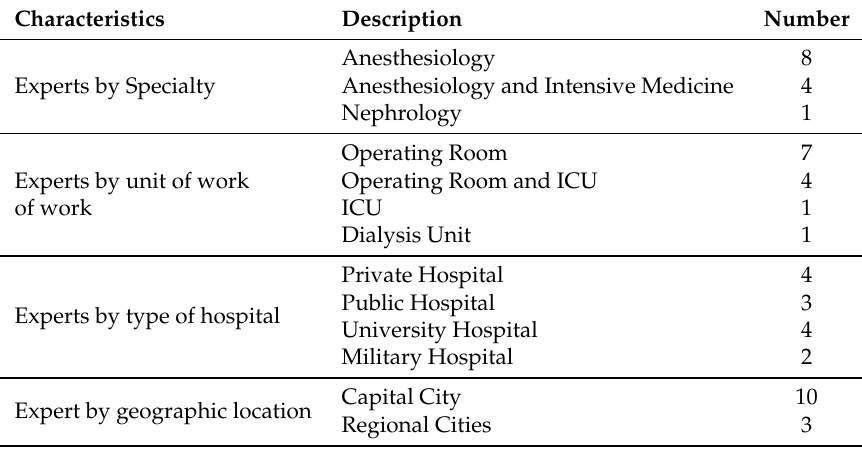
Table 1. Characteristics of the participants in the Delphi